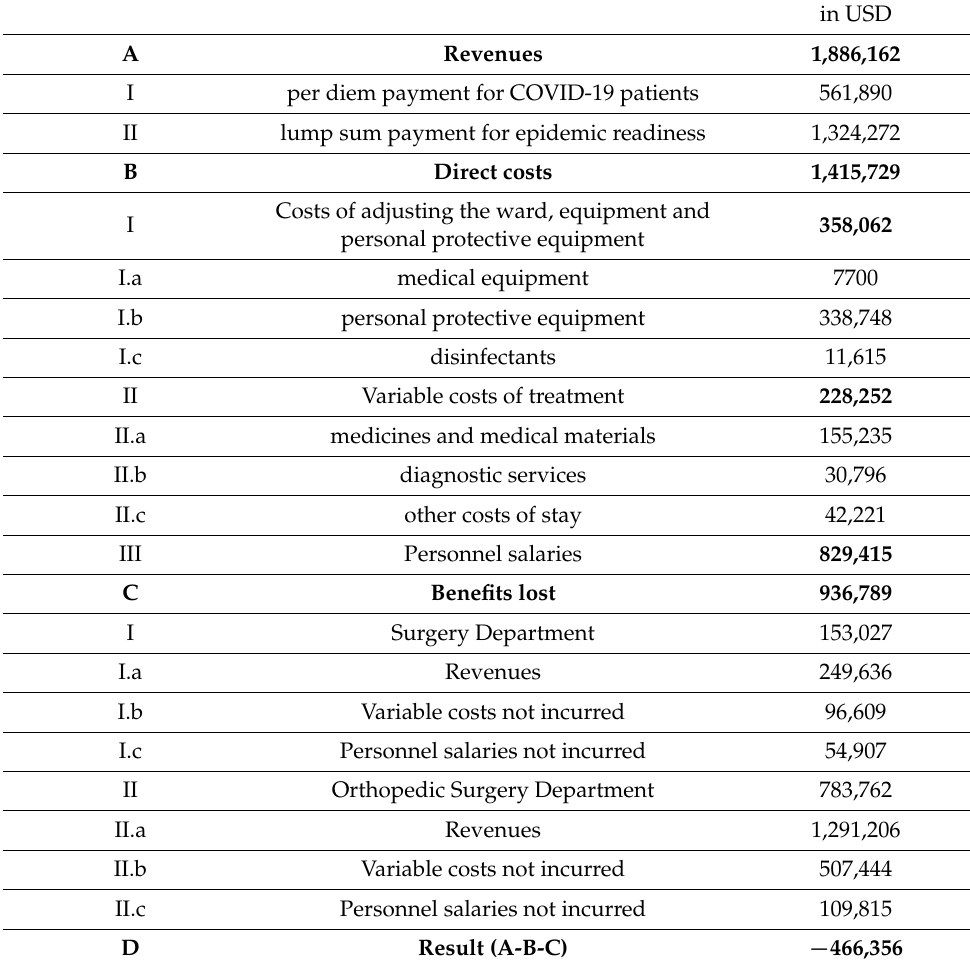
Table 1. Analysis of the financial consequences of the organization of the COVID-19